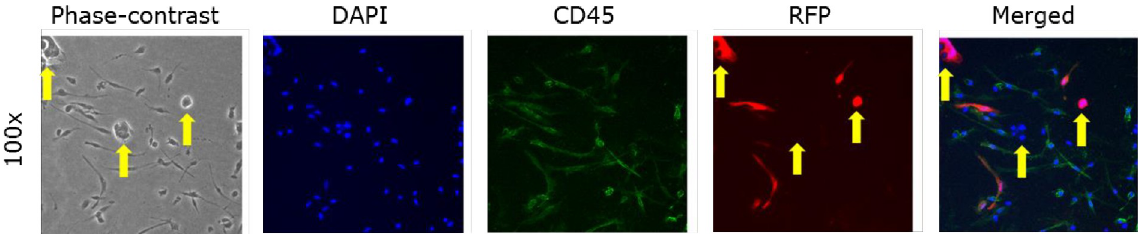
Fig 4. Direct transmission of RSV from Hofbauer cells to na ï ve 16HBE. Hofbauer cells were infected at a MOI of 0.01 and incubated for 48 hours, after which uninfected 16HBE cells were seeded for co-culture. After 72 hours of co-culture, the cells were fixed for analysis of RFP expression by fluorescence microscopy. The characteristic epithelial “colonies” formed by 16HBE cells (yellow arrows) and the CD45 staining (green) identifying Hofbauer cells allowed to recognize the two cell types. RFP expression (red) and syncytia formation was observed in 16HBE cells at 72 hours, indicating transmission of the infection from the Hofbauer cells to the epithelial